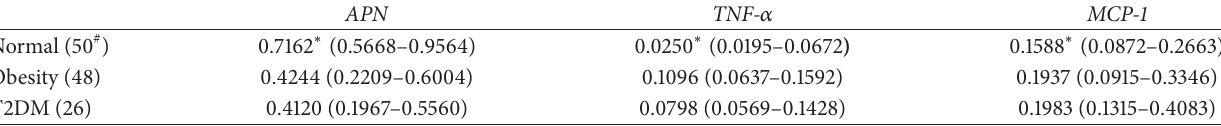
Table 4: Comparison of adipose cytokines mRNA copy data in the visceral adipose tissue of Uygur population (rank sum test).